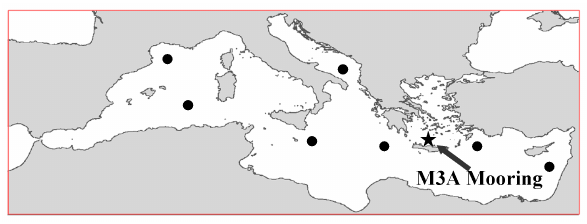
Fig. 4. Location of the M3A system during the pilot phase of MFS (star) and buoy locations during the second Phase of MFS according to the science plan (filled